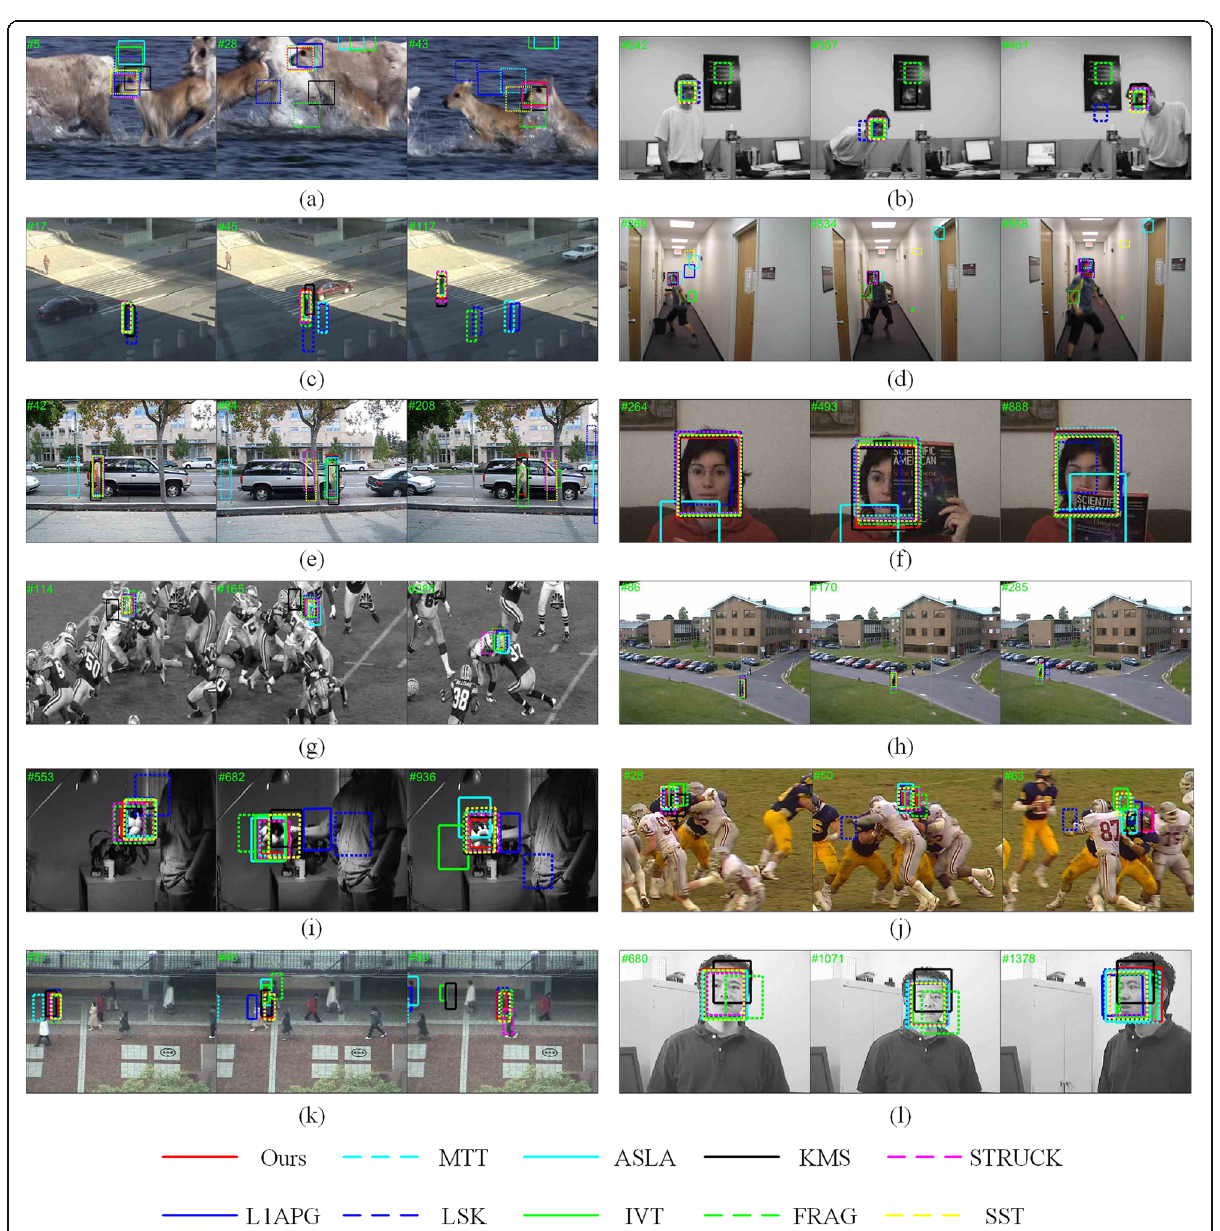
Fig. 2 a – l Qualitative comparisons. Tracking results of our algorithm and other 9 state-of-the-art tracking method on some representative frames of 12 sequences (deer, david2, crossing, boy, david3, faceOcc1, football, walking, sylvester, football1, subway, and mhyang, from left to right and top to bottom). Result of our method is marked with red